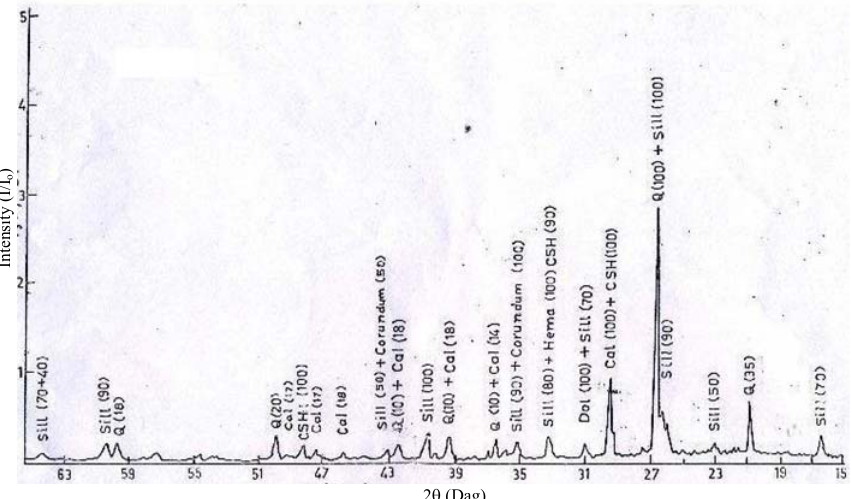
Figure 7. XRD pattern of steam-cured LFAS cube containing Cr (OH)